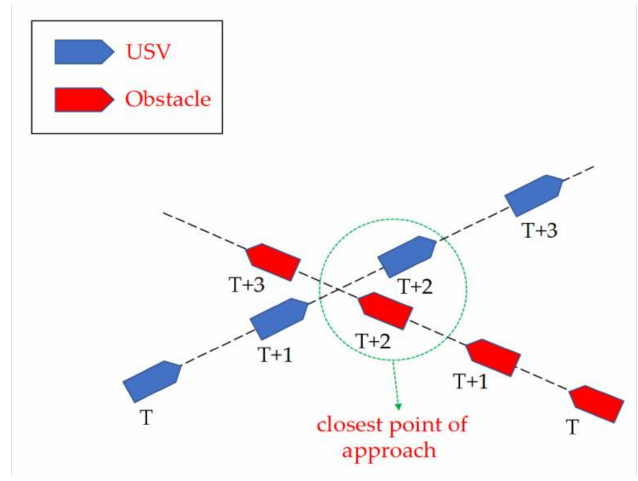
Figure 2. The principle of the closest point of